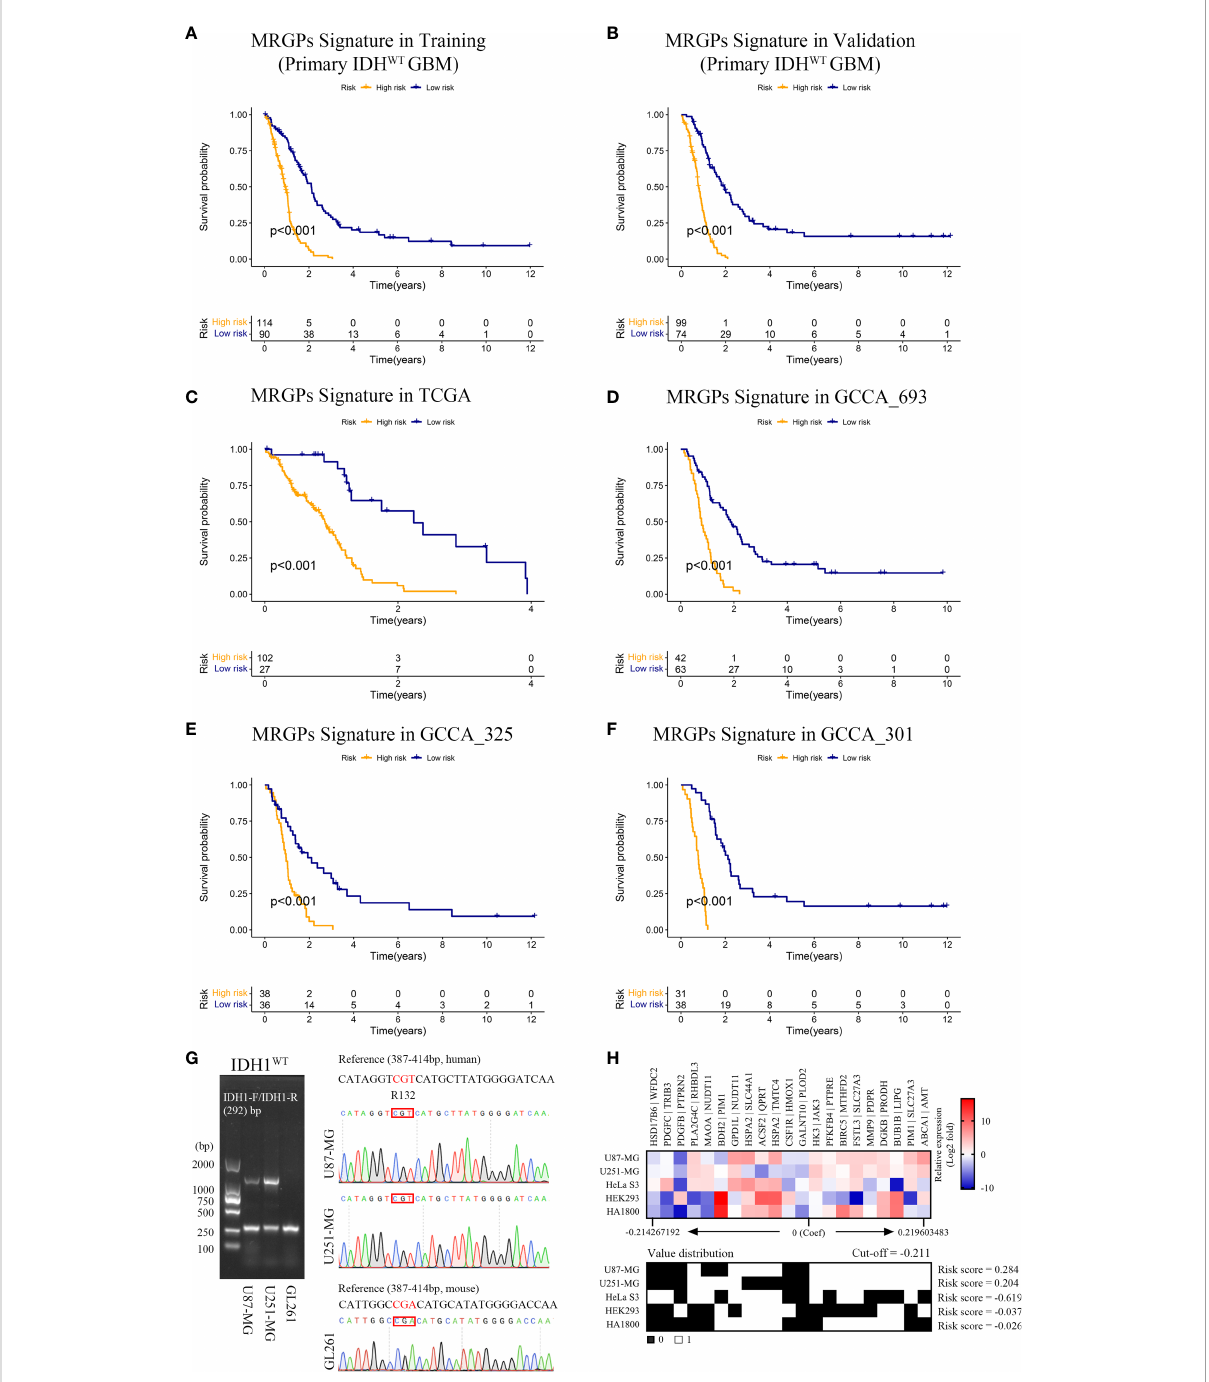
FIGURE 2 MRGPs Signature Strati fi es the Overall Survival of IDH WT GBM With Different MRGP Risks. Kaplan – Meier curves of overall survival in IDH WT GBM patients in the MRGP risk groups. The overall survival of patients in the training (A) and validation (B) datasets was strati fi ed by the MRGP risk score. The overall survival of IDH WT GBM in TCGA (C) , CGGA_693 (D) , CGGA_325 (E) , and CGGA_301 (F) datasets was strati fi ed into high- and low-risk groups based on MRGP risk score ( P values are all < 0.001, log-rank test). (G) Identi fi cation of IDH1 gene status in human GBM cells. No mutations were observed at the R132 site in the U87-MG and U251-MG cell lines. (H) Validation of the predictive ef fi cacy of the MRGPI for human GBM cell lines. RT – PCR assays were performed to identify the expression levels of 38 MRGs relative to GAPDH in GBM cell lines and the control cell lines (HeLa S3, HEK293, and HA1800). The relative expression data between MRGs were used to calculate the risk level of cell lines in vitro . The cut-off value is equal to -0.211. GBM cell risk scores were all greater than the cut-off value (U87-MG = 0.284, U251-MG = 0.204), indicating high